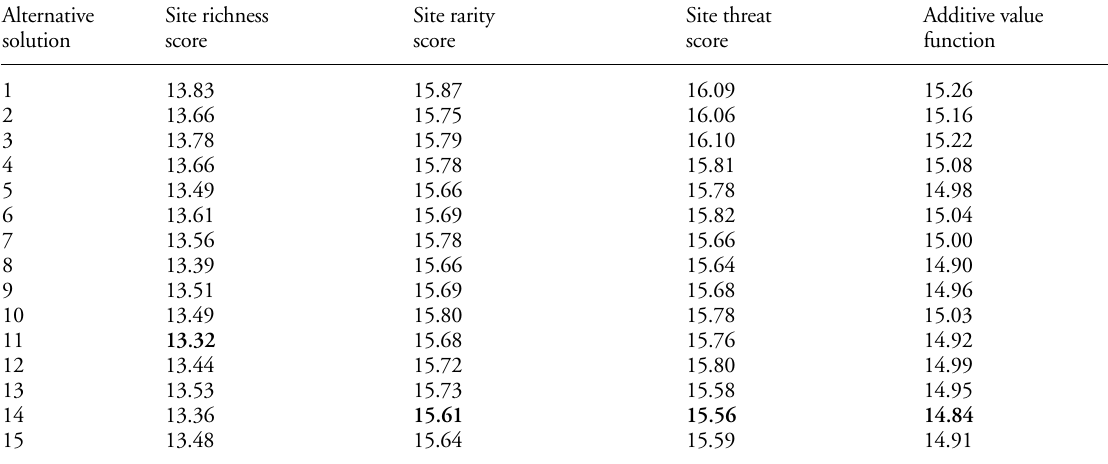
Table 2. Alternative optimal solutions, their corresponding site-richness, rarity and threat scores as well as their additive value function scores. The best solution according to the additive value function coincides to the particular one according to site rarity or threat. The same solution was also found by the application of the goal programming method. Bold values are the optimum scores found accord- ing to site richness, site rarity, site threat and additive value function scores respectively.